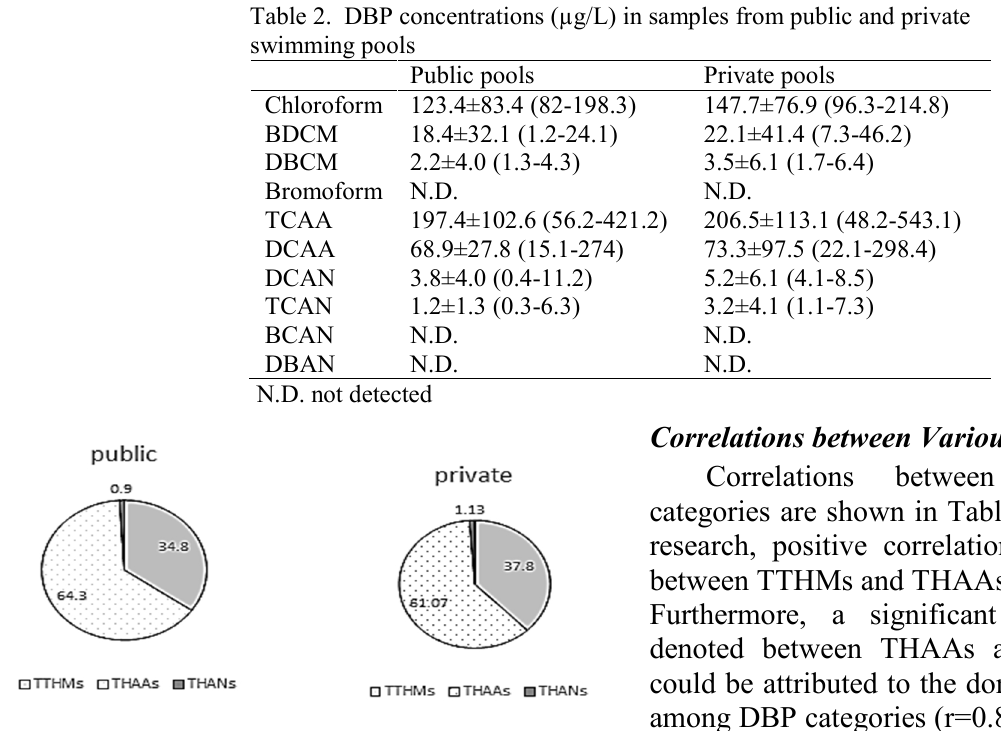
Fig. 2. Distribution of DBPs in samples from public and private swimming